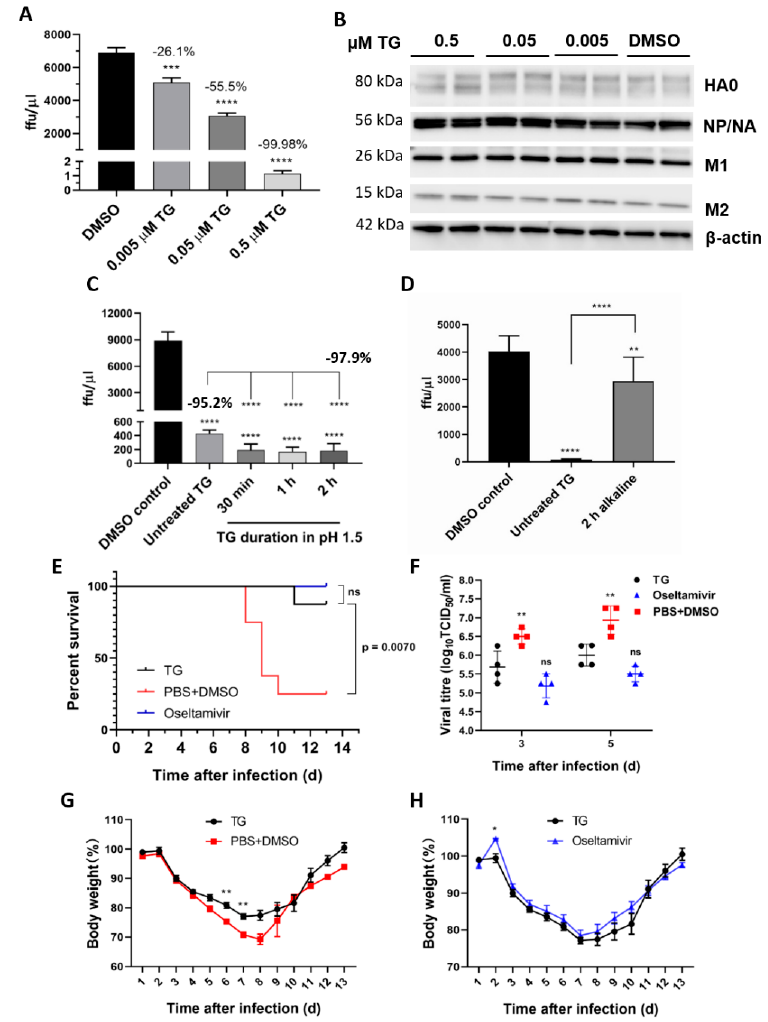
Figure 7. TG post-translationally inhibits the influenza A virus, is acid-stable and therapeutically protects mice in a lethal virus challenge. ( A ) A sharp reduction in influenza progeny production from the TG-primed NPTr cells was ( B ) accompanied by no detectable reduction in viral proteins. Cells were primed with TG for 30 min, washed twice with PBS and infected with USSR virus at 0.5 MOI for 2 h; after which cells were again washed 3 times with PBS and incubated in serum-free media, supplemented with TPCK trypsin at 0.2 µgl/mL, for 24 h. ( A ) A focus forming assay was performed with the corresponding media samples to determine viable virus production (ffu/µL). The indicated significance is based on one-way ANOVA (Dunnett’s multiple comparisons) and the percentage viable progeny relative to the corresponding DMSO control. ( B ) Viral proteins, including those processed through the ER–Golgi apparatus (HA, NA and M2), showed no reduction in TG-primed cells. ( C , D ) Antiviral activity of TG was stable in acidic but not alkaline condition. ( C ) TG used was first incubated in pH 1.5 (in 30 mM hydrochloric acid) for different durations, as indicated, and neutralised with sodium hydroxide before being applied to cells for 30 min at a 0.5 µM final concentration. ( D ) TG used was first incubated in pH 12.0 (10 mM sodium hydroxide) for 2 h and neutralised with hydrochloric acid before being applied to cells for 30 min at a 0.5 µM final concentration. Twenty-four hours post-infection with the USSR H1N1 virus at 0.5 MOI, the infected culture media were used in 6 h focus forming assays to immuno-detect the viral NP to determine the progeny virus output (ffu/µL). Unless otherwise indicated, the significance is based on one-way ANOVA Tukey’s multiple comparison and percentage virus reduction are in relation to the corresponding DMSO control. ( E – H ) Therapeutic protection of TG in a lethal influenza virus challenge in mice. Each BALB/c mouse ( n = 8 per group) in a group was intranasally infected with 3 MLD 50 of PR8/H1N1 virus. Each mouse was then dosed orally once a day with TG (1.5 µg/kg/day), oseltamivir (45 mg/kg/day) or PBS+DMSO for 5 days; the first dose was given at 12 hpi. Survival rates ( E ), viral titres in the lung by TCID 50 assays ( F ) and body weight changes ( G , H ) were recorded over 14 d. Each time point represents the mean ± SEM. The Kaplan–Meier method was used for survival analysis. Significance indicated relative to the corresponding TG group. * p < 0.05, ** p < 0.01, *** p < 0.001 and **** p <